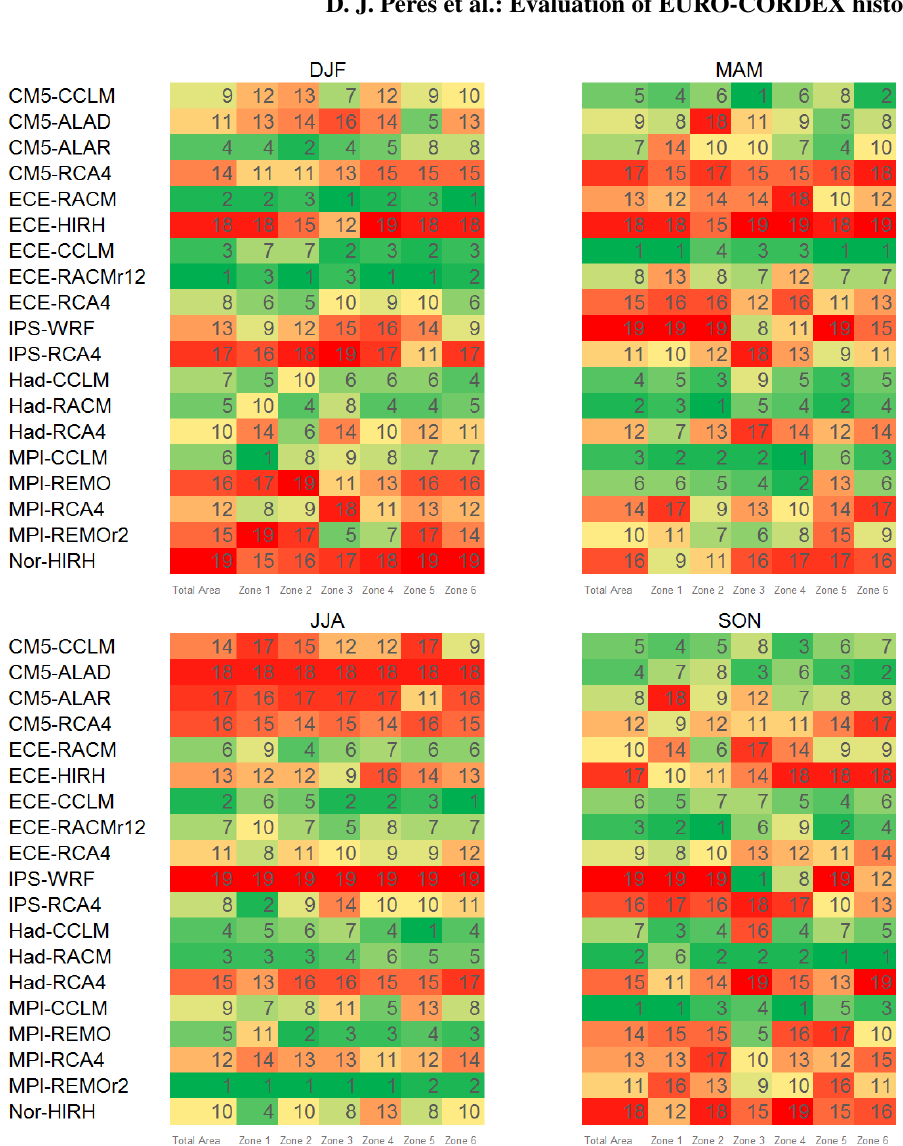
Figure 10. As Fig. 5 but for seasonal